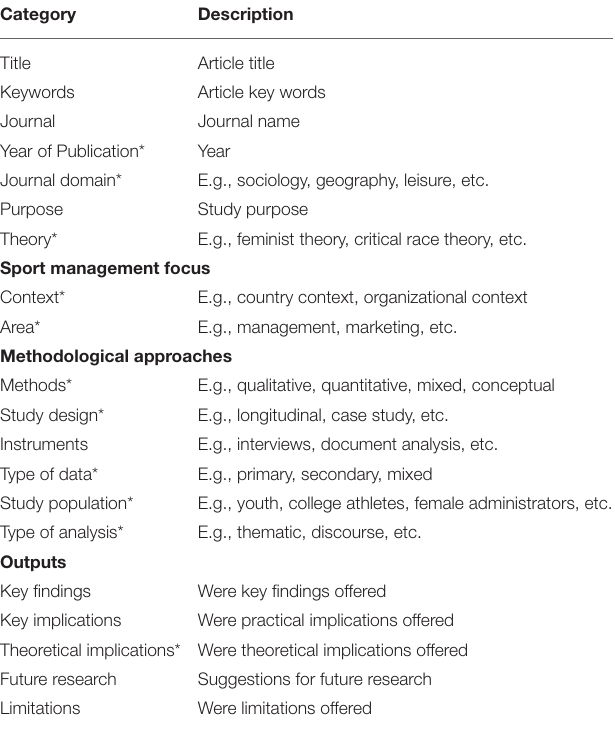
TABLE 1 | Data extraction